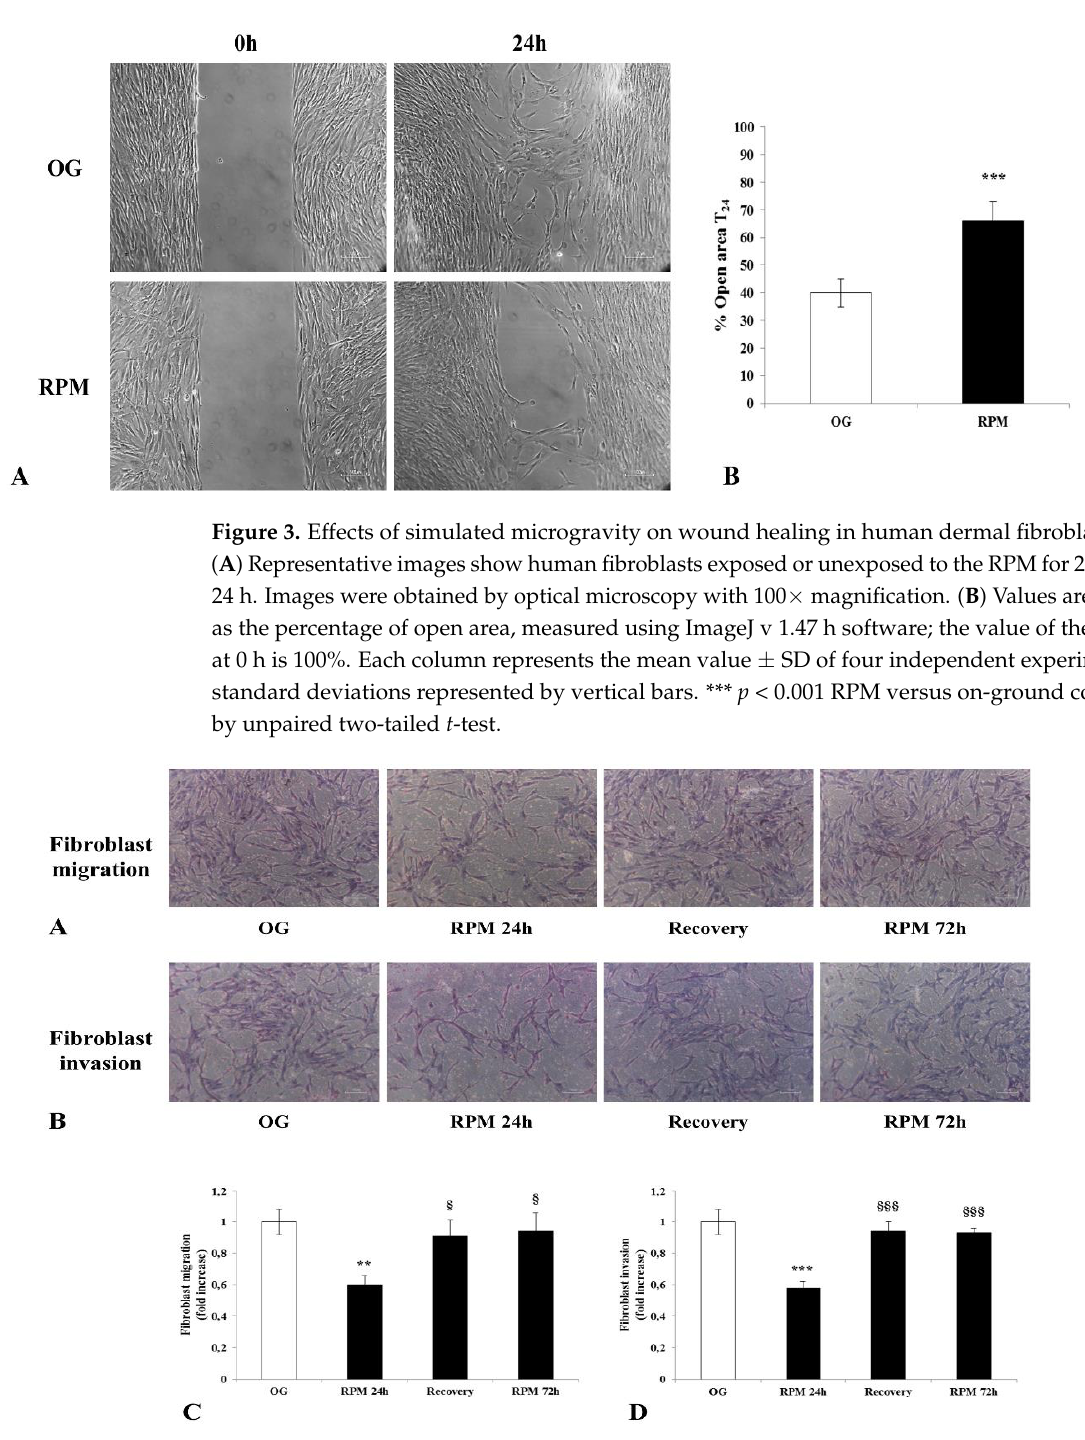
Figure 5. Effect of simulated microgravity on MMP-9 ( A ) and MMP-2 ( B ) activity in human dermal fibroblasts. Gelatin zymography shows MMP-9 and MMP-2 activity in conditioned media of human